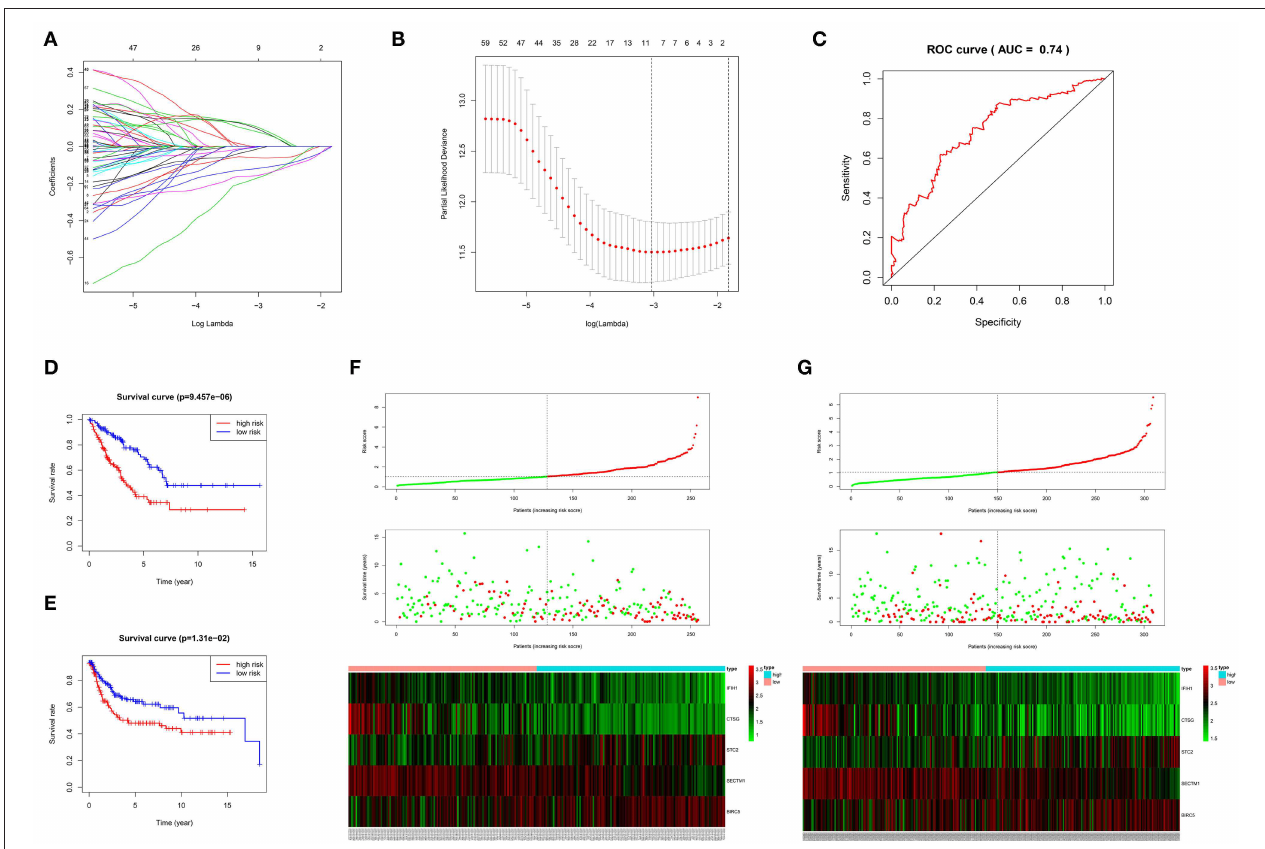
FIGURE 3 | Construction, validation, and assessment of the prognostic model. (A,B) Identification of prognostic genes using the least absolute shrinkage and selection operator (LASSO) regression analysis. (A) Coefficients of the LASSO regression analysis. (B) Selection of tuning parameters based on the 1000 cross-validations method. (C) The receiver operating characteristic (ROC) curves of the prognostic model in TCGA dataset. The survival curve for high- and low-risk patients in TCGA (D) and GSE21050 (E) datasets. Differences in risk score, survival time, and gene expression of the optimal immune-related prognostic genes (IRPGs) between high- and low-risk patients from TCGA (F) and GSE21050 (G) datasets.